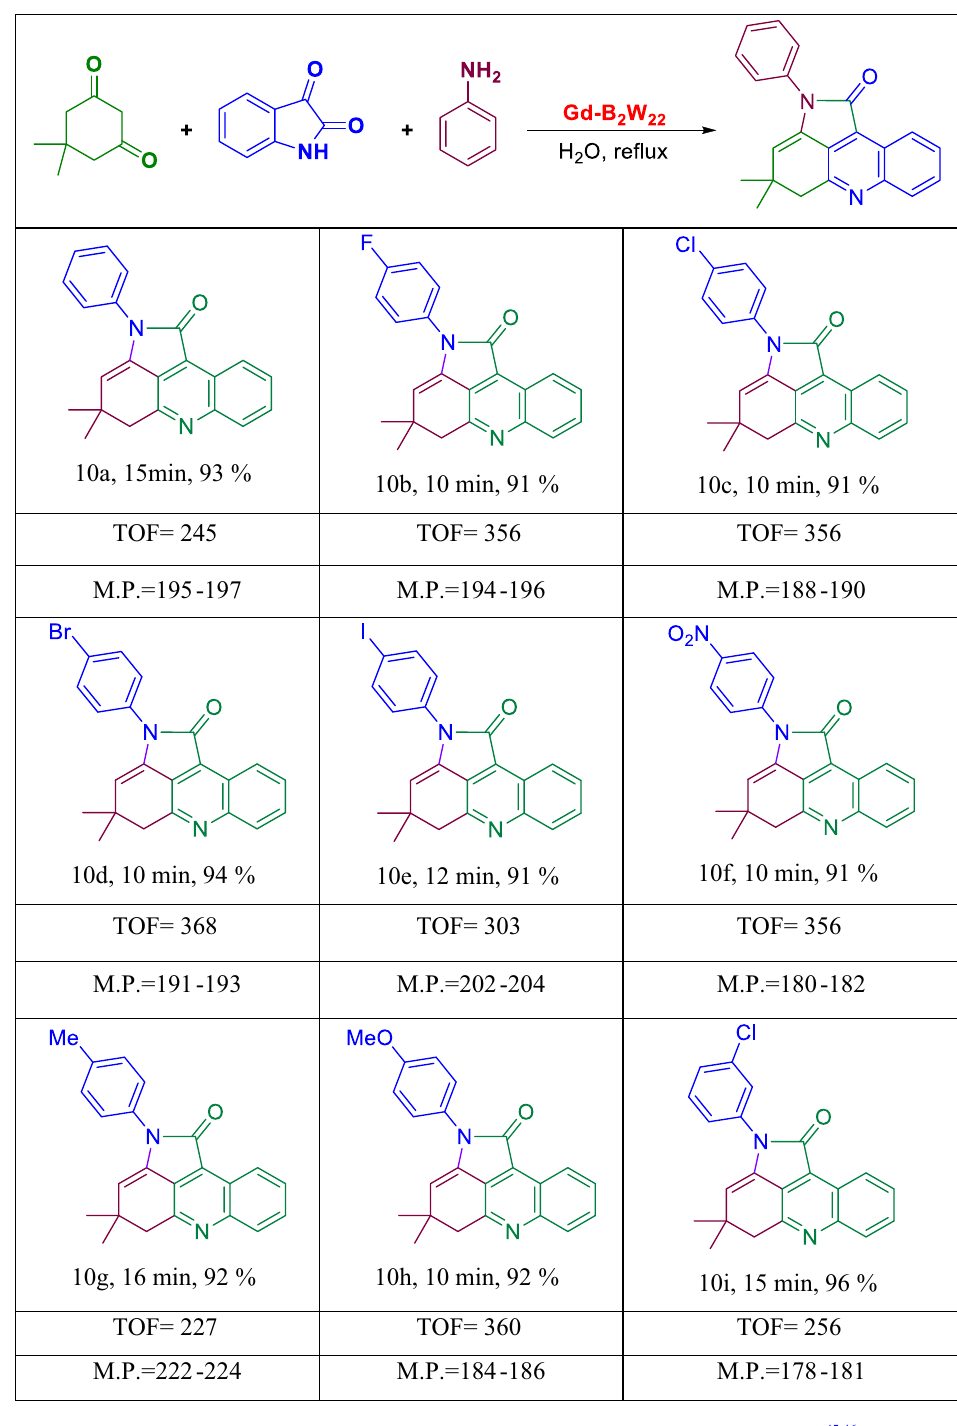
Table 5. One-pot, three-component synthesis of pyrrolo[2,3,4-kl]acridin-1-one derivatives 45,46